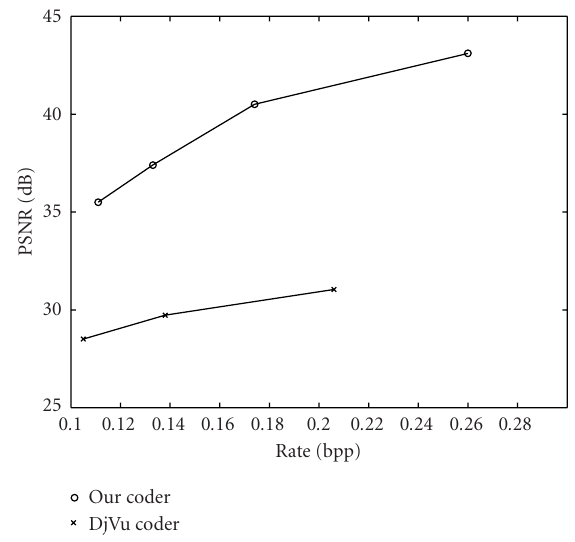
Figure 3: Rate-distortion performance comparison for cmpnd1 be- tween our two-class coder and OBTS coder [1].